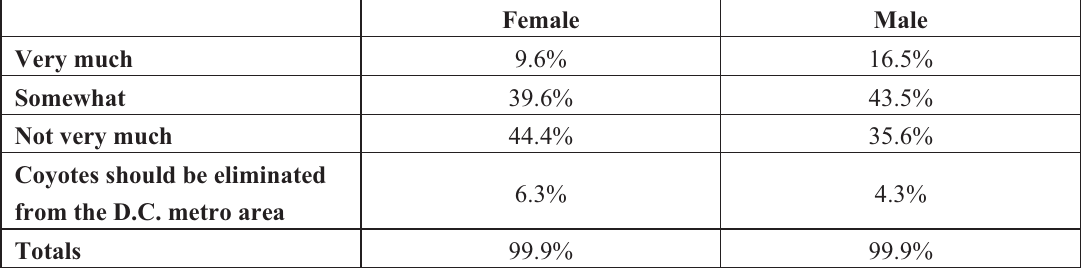
Table 16. The relationship between gender and how much the respondents supported the presence of coyotes in the D.C. metro area. Results of a Chi-Square test for